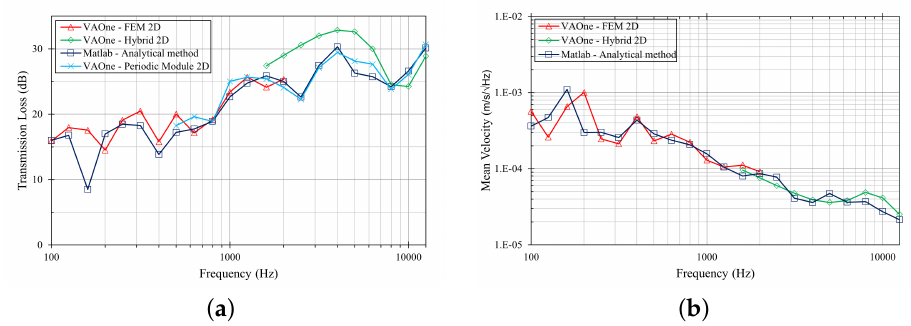
Figure 12. Vibro-acoustic responses of a panel with symmetrical Z stiffeners (2D stringers): ( a ) sound transmission loss and ( b ) space-average mean vibration